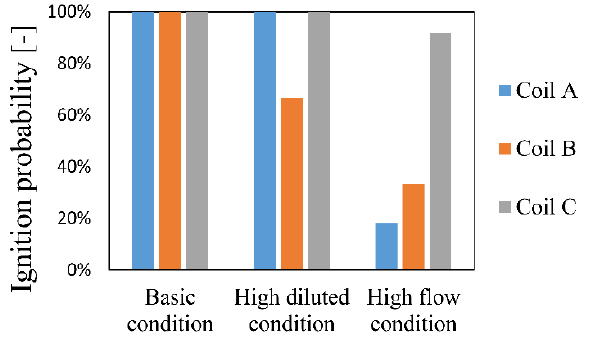
Figure 7. Ignition probability of all the conditions.